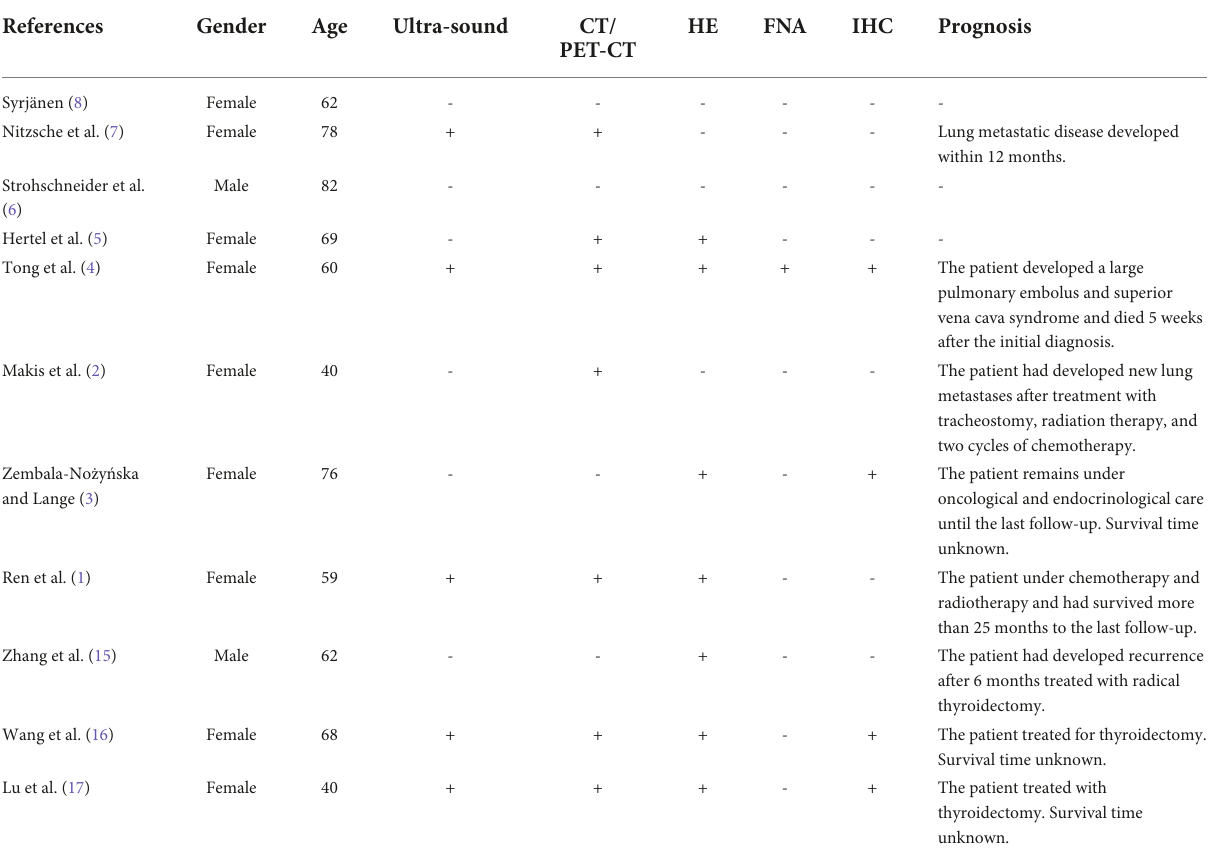
TABLE 1 Previous studies of primary thyroid